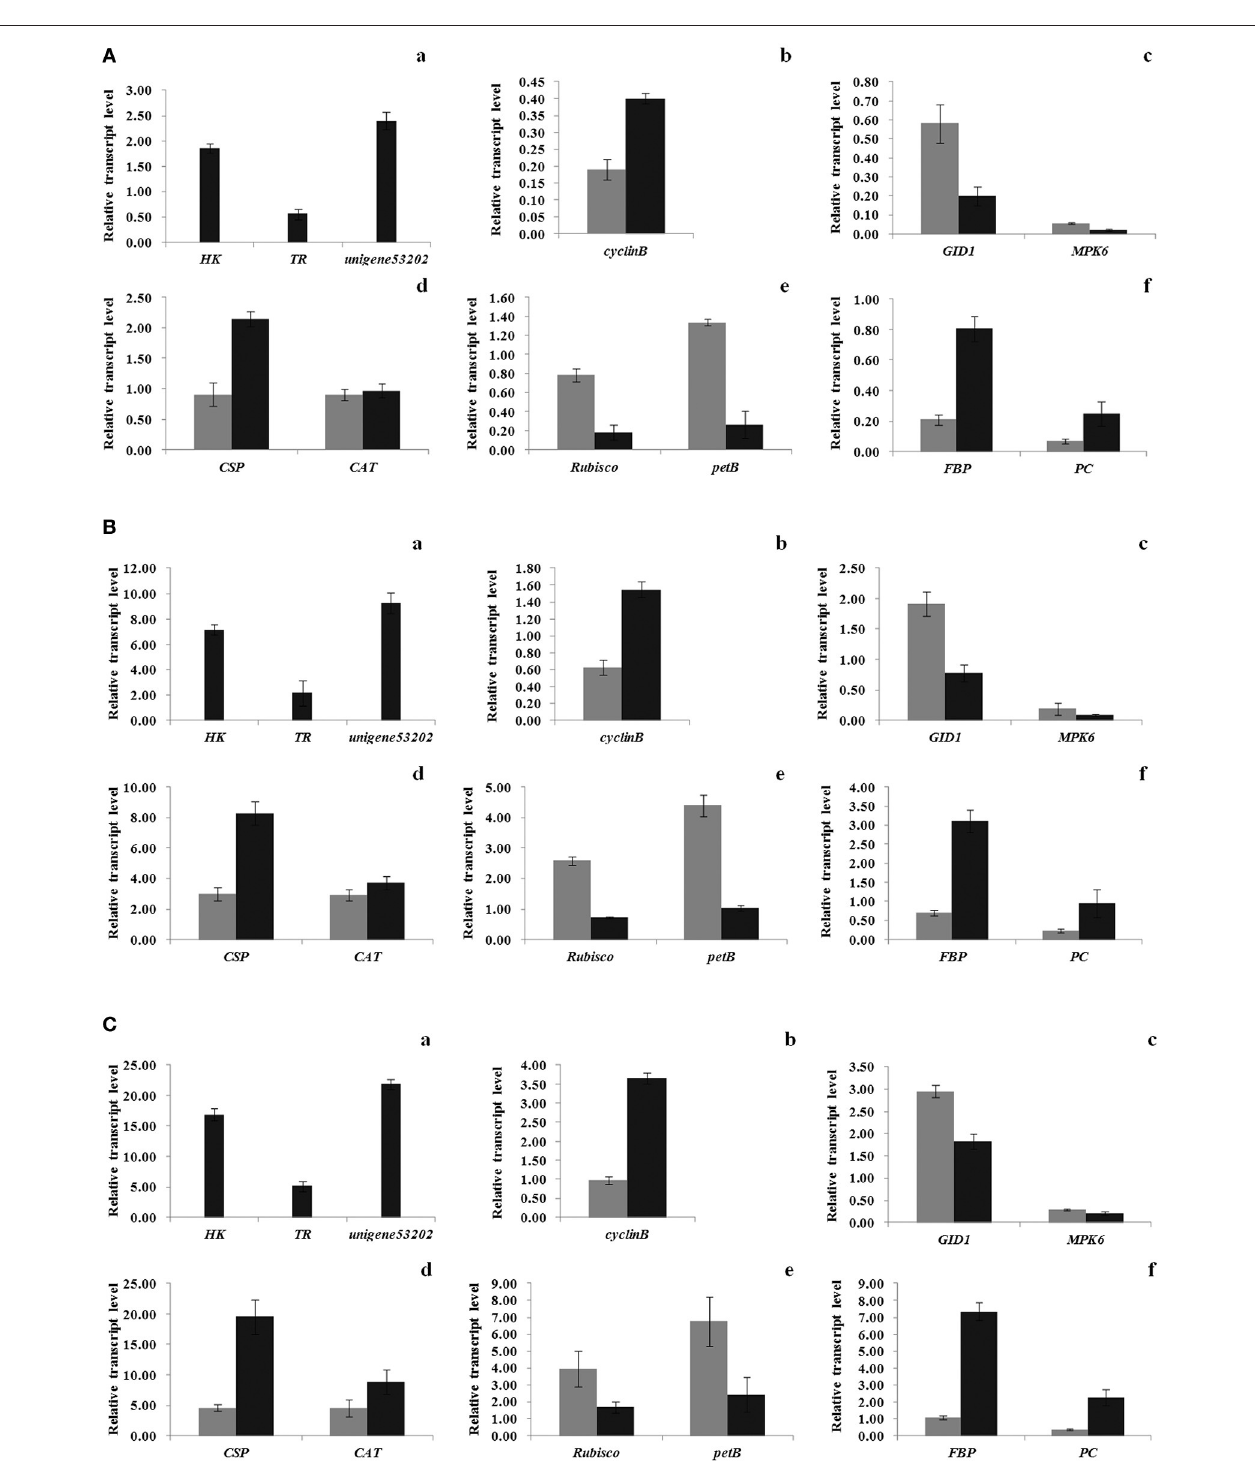
FIGURE 6 | Verification of expression levels for selected unigenes from the RNA-seq via qPCR. Total RNA was extracted from vegetative cells and resting cysts of Scrippsiella trochoidea , respectively. Relative expression levels of unigenes are presented as the expression normalized to the reference gene (A) MDH , (B) LBP , and (C) UBC , resectively. For each reference gene, the expression levels are presented for unigenes (a) specifically expressed in resting cyst, (b) relevant to cell cycle, (c) relevant to phytohormones signal transduction, (d) relevant to environmental adaptation, (e) relevant to photomorphogenesis, and (f) relevant to energy metabolism. For each gene, the gray and black bars indicate the gene expression for vegetative cells and resting cysts, respectively. Values are mean ± standard deviation, Error Bars = SD, n = 3.